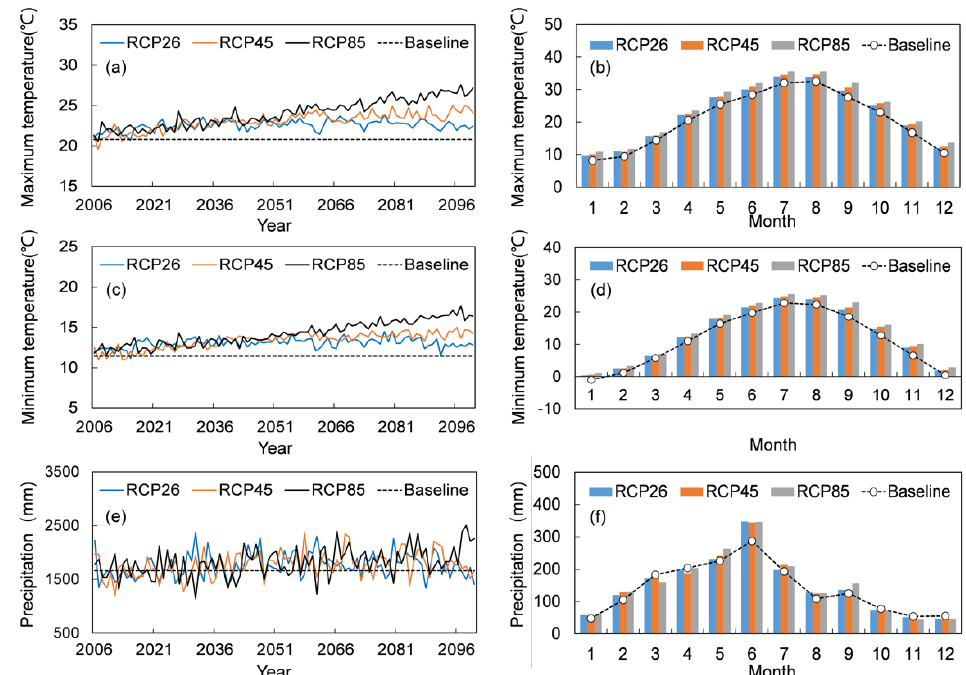
Figure 3. The time series of annual maximum temperature ( a ), annual minimum temperature ( c ), annual precipitation ( e ), monthly maximum temperature ( b ), monthly minimum temperature ( d ), and monthly precipitation ( f ) averaged over XRB projected by downscaled CMIP5 GCM (CSIRO-Mk3-6-0) in 2006–2100 under RCP2.6, RCP4.5 and RCP8.5, respectively. The solid lines and histograms indicate CSIRO-Mk3-6-0 outputs of different RCPs, the dotted line is the mean values of annual meteorological elements of the basin in baseline (1973–2005). The dashed line with circles indicates the mean values of monthly meteorological elements.